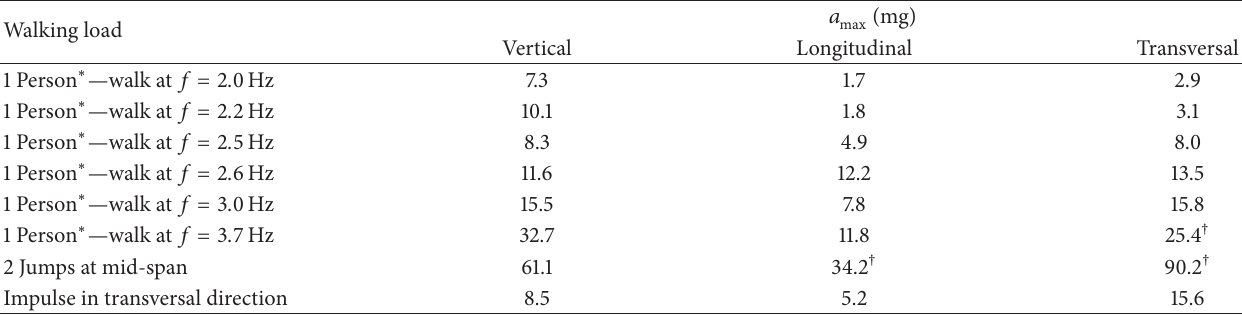
Table 8: Peak acceleration amplitudes for different tests.